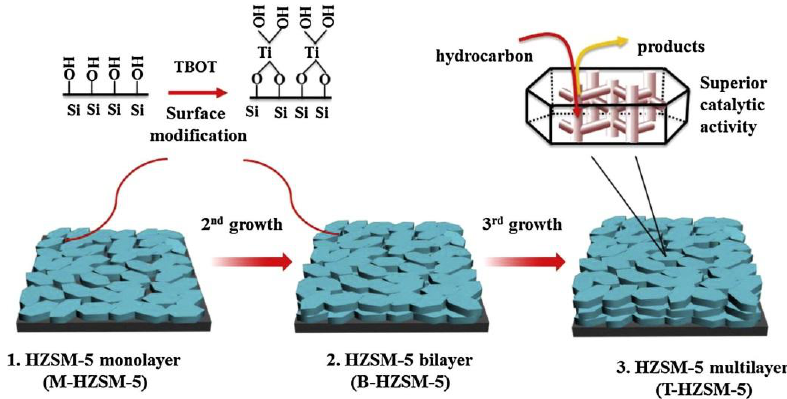
Figure 6. Scheme of the layer-by-layer hydrothermal synthesis of multilayer HZSM-5 coatings via surface modification process using titanium alkoxide solution. TBOT, tetra n-butyl ortho-titanate [57]. Copyright Elsevier, 2014.